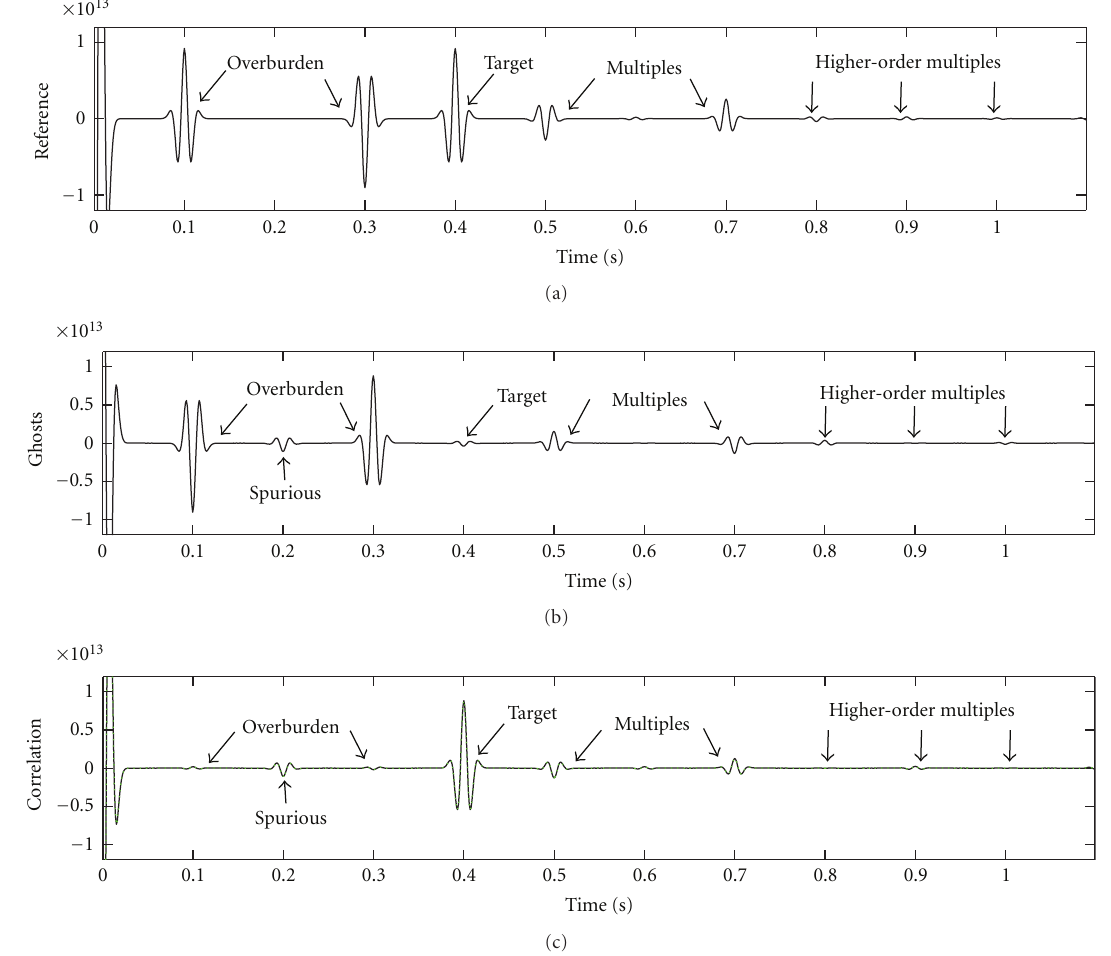
Figure 5: Cross-correlation of full fields for model B: (a) reference response by placing an active source at the virtual source location x A ; (b) computed ghost terms g S + g O ; (c) causal part of the correlation function C (black) and the sum of reference response + ghosts (dashed